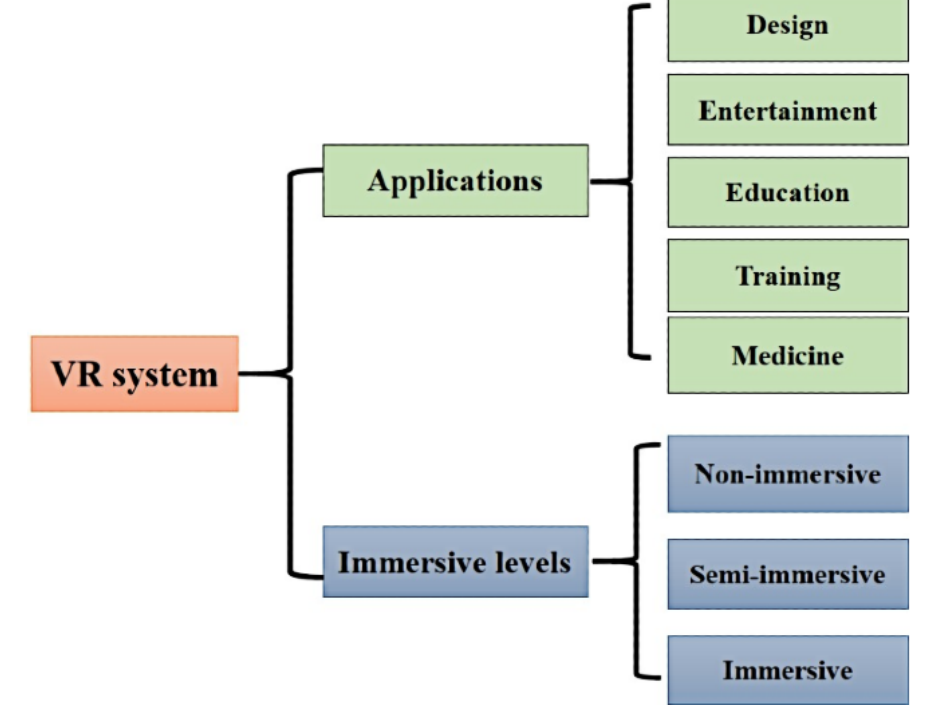
Figure 3. Applications and immersive levels of virtual reality (VR)